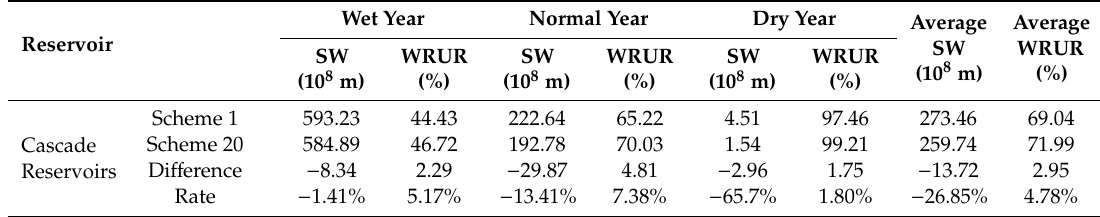
Table 5. Comparison of spilled water and water resource utilization rates between scheme 1 and scheme